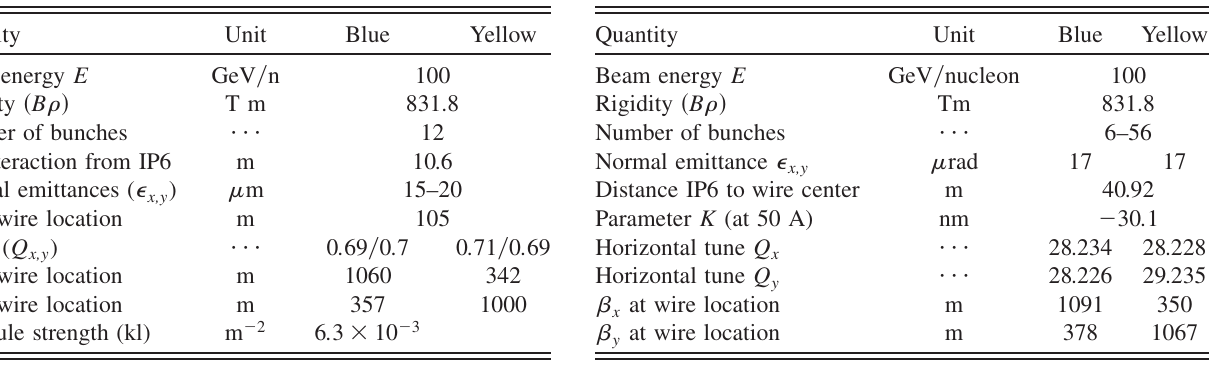
TABLE V. RHIC parameters for experiments with DC